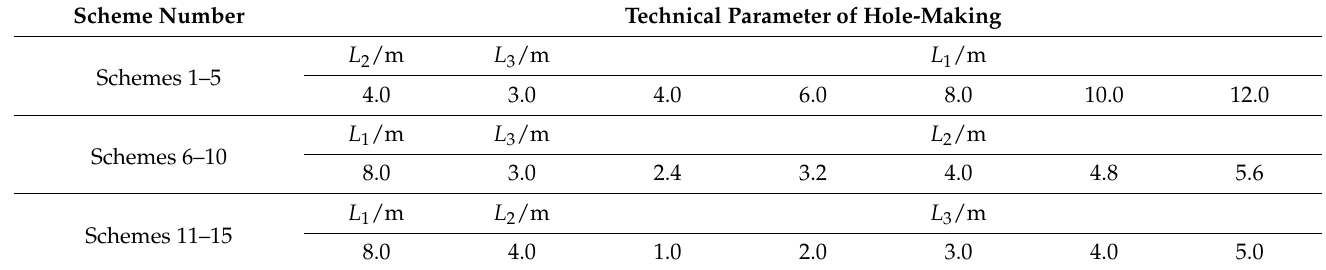
Table 2. Numerical simulation